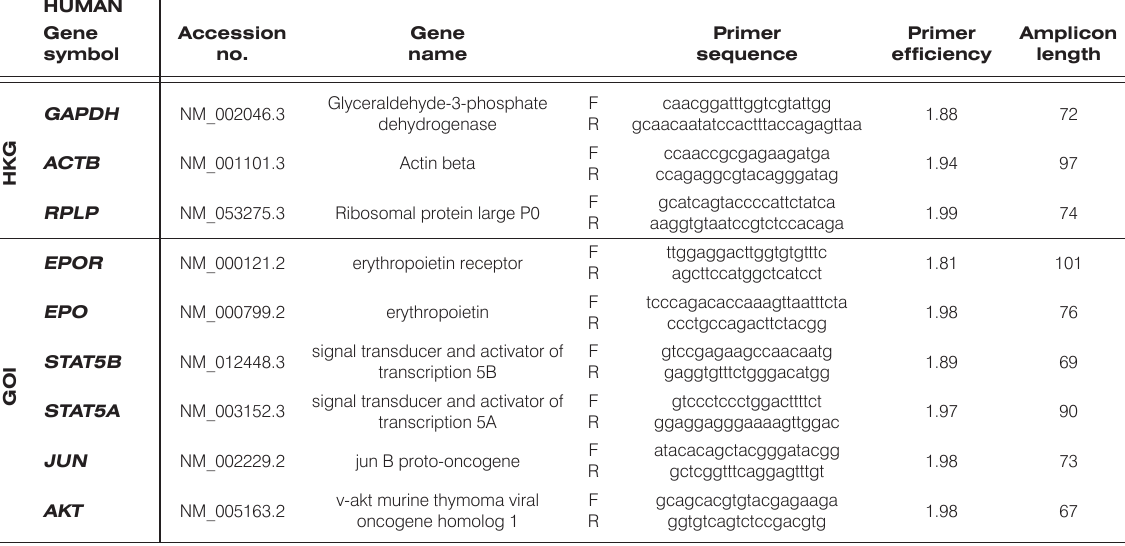
Table 3. Housekeeping genes (HKG) and genes of interest (GOI) evaluated in PC12 rat cell line. RAT Gene Accession symbol